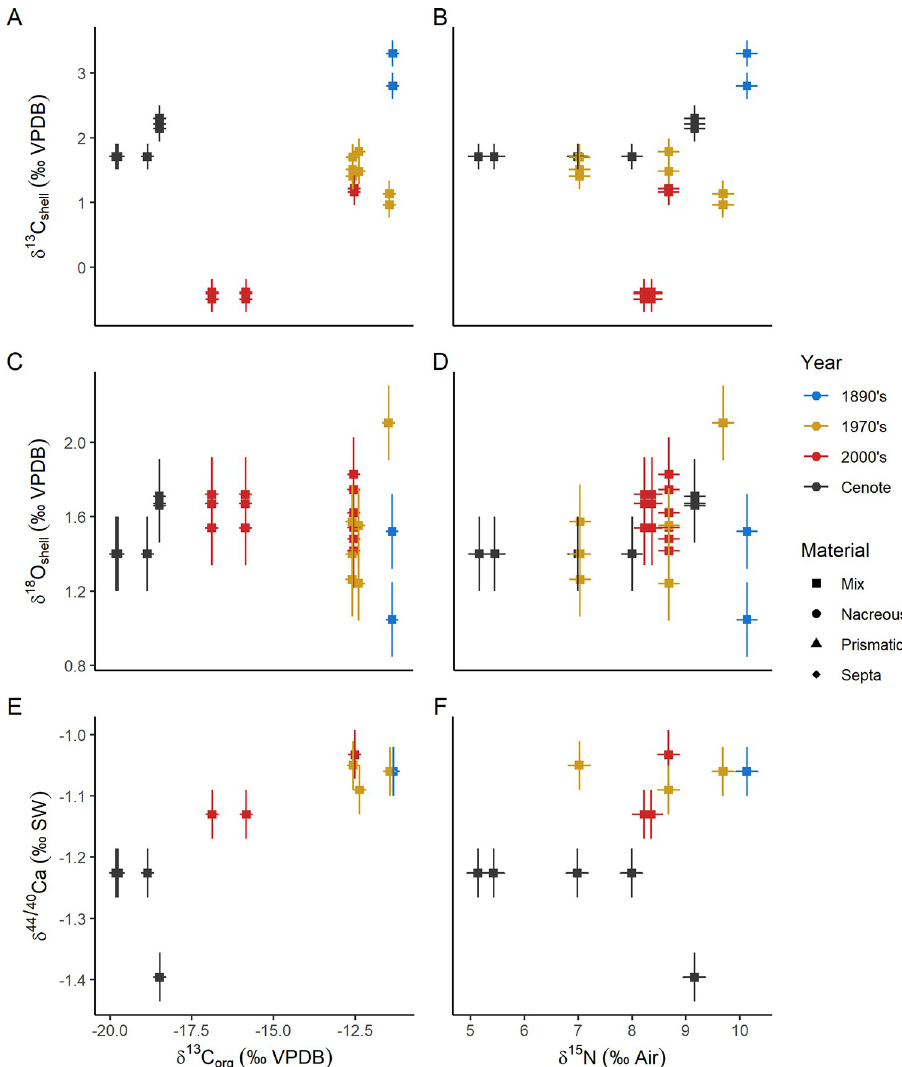
Fig 8. Crossplots of isotope values measured in shell organic matter vs shell carbonate. Error bars are 2 standard deviation instrumental precision. A) δ 13 C org vs δ 13 C shell , B) δ 15 N vs δ 13 C shell , C) δ 13 C org vs δ 18 O shell , D) δ 15 N